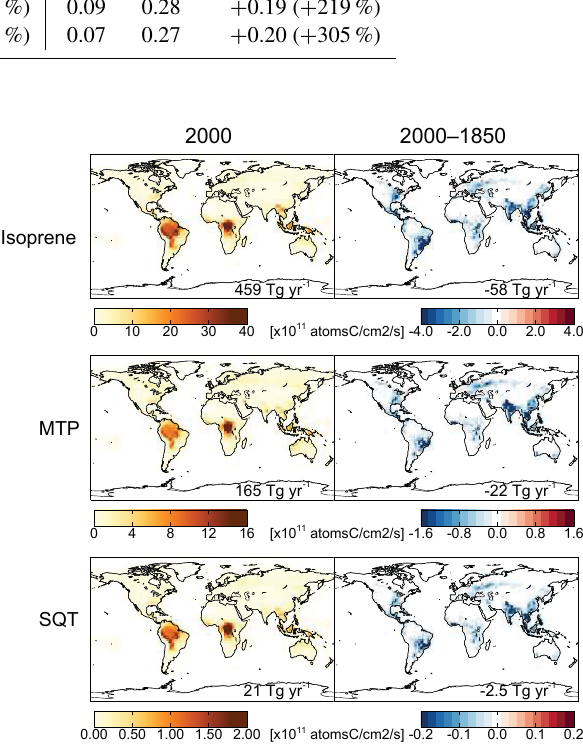
Figure 4. Annual mean simulated emissions of BVOCs from veg- etation. Total emissions for present day (2000) shown on the left; the change due to historical land use change is shown on the right. Global annual emission values are shown